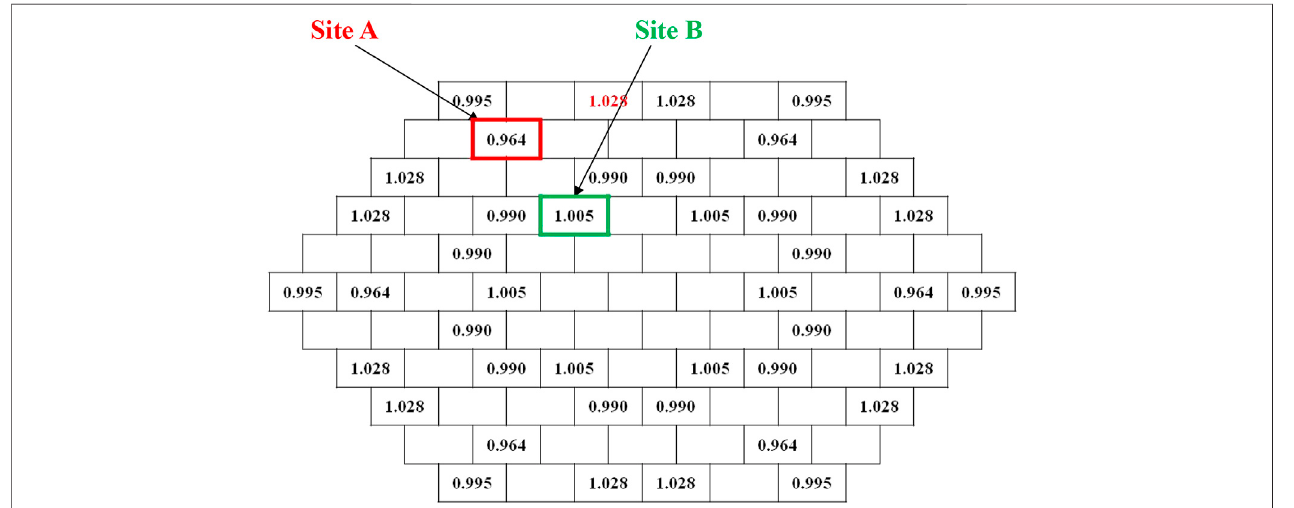
FIGURE 12 | Relative power distribution of S-CO 2 assembly using the partitioning method (BOL).